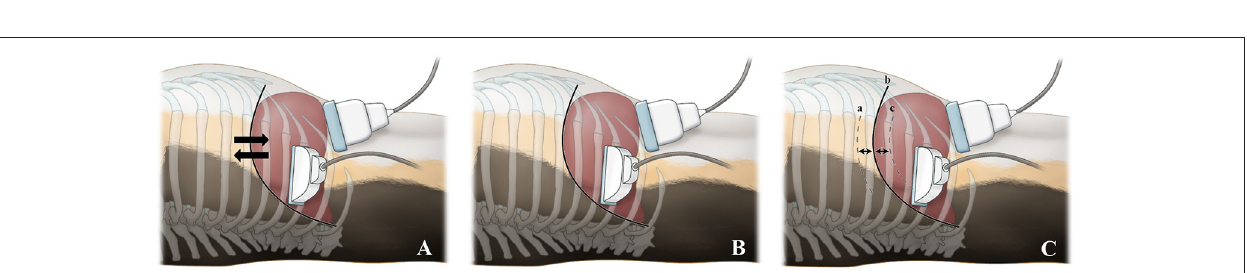
( Figure 2 ). For forced-expiration, 50-cc syringes connected to the endotracheal tube were pulled manually, drawing the air out from the airway and inducing expiration. The number of syringes used was selected based on the functional residual capacity of the lung in accordance with the body weight of each dog (5 and 10 mL/kg). The baseline used in this study was lower than that reported in the veterinary literature to ensure the safety of the dogs